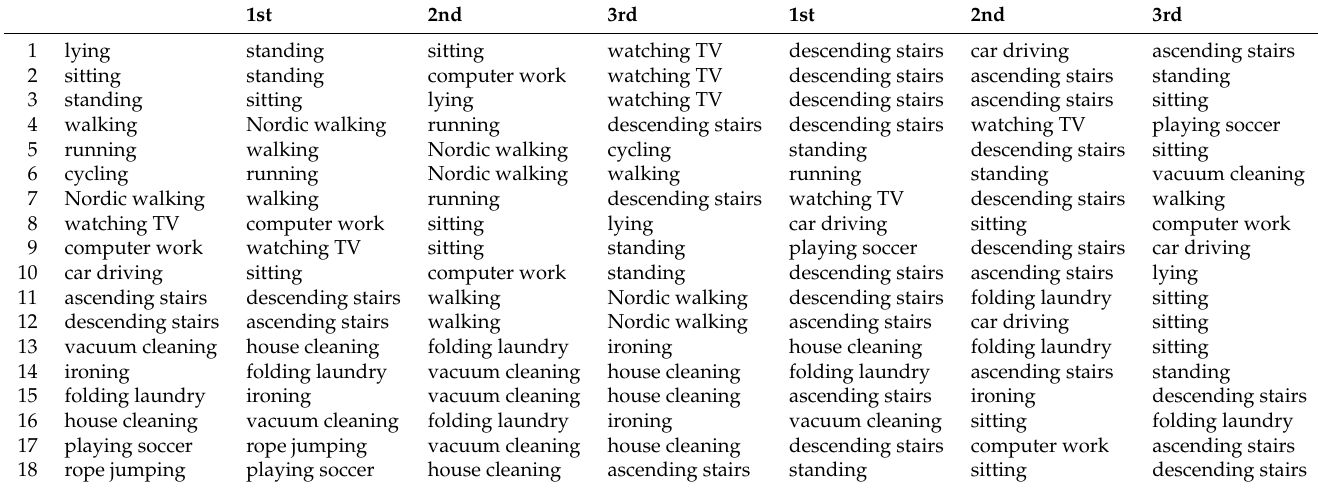
Table A7. Top 3 nearest words in the attribute space (left) and the embedding space (right) for the PAMAP2 dataset.